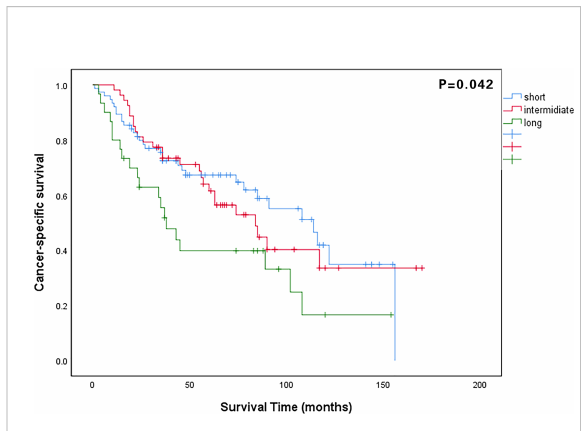
FIGURE 2 Comparison of cancer-speci fi c survival curves among patients in the long, intermediate, and short waiting time